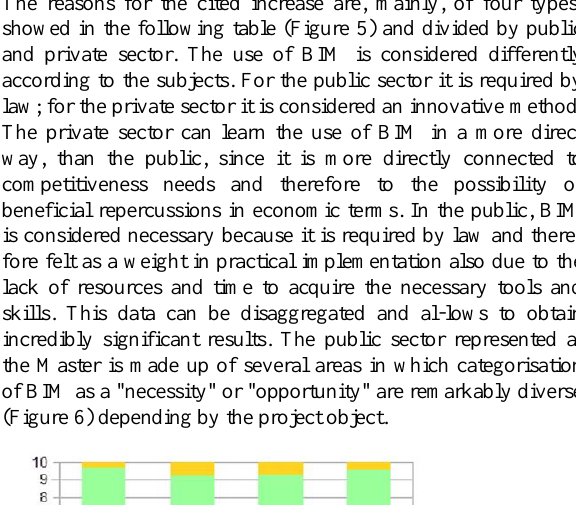
Figure 7. Impact of BIM in public works: Heritage - Other (Figure by P.